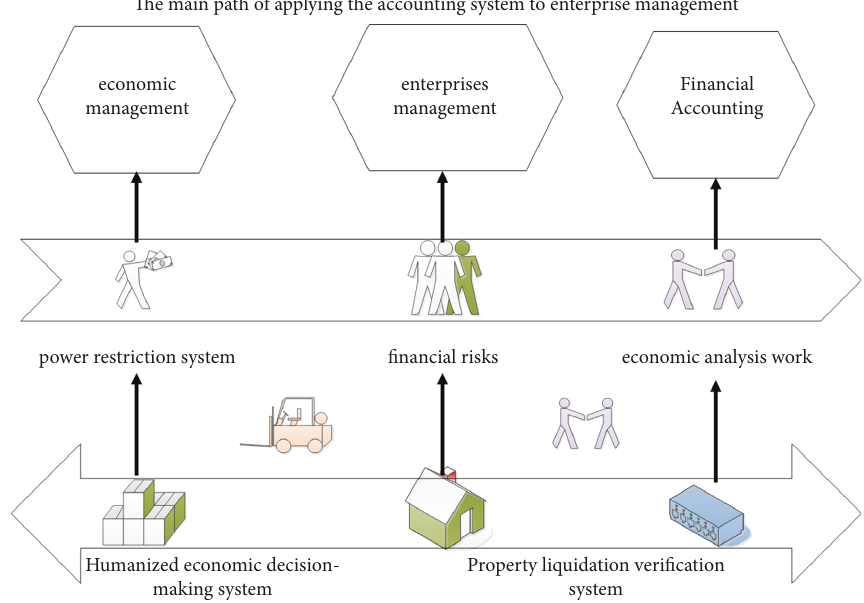
Figure 2: The main path of applying the accounting system to enterprise